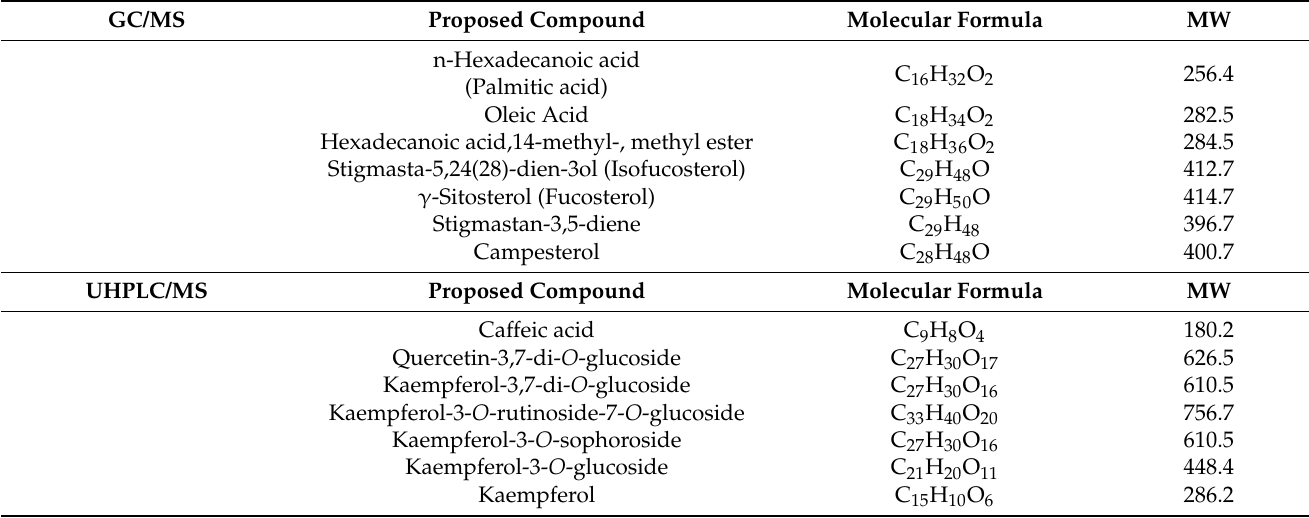
Table 5. Compounds identified by GC-MS and UHPLC-MS in S4 (EtOH-W)